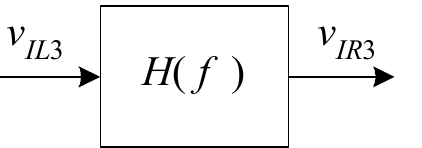
Figure 5. Signal chain equivalent of the relationship between signals v IL 3 and v IR 3 as obtained in Equation (16).